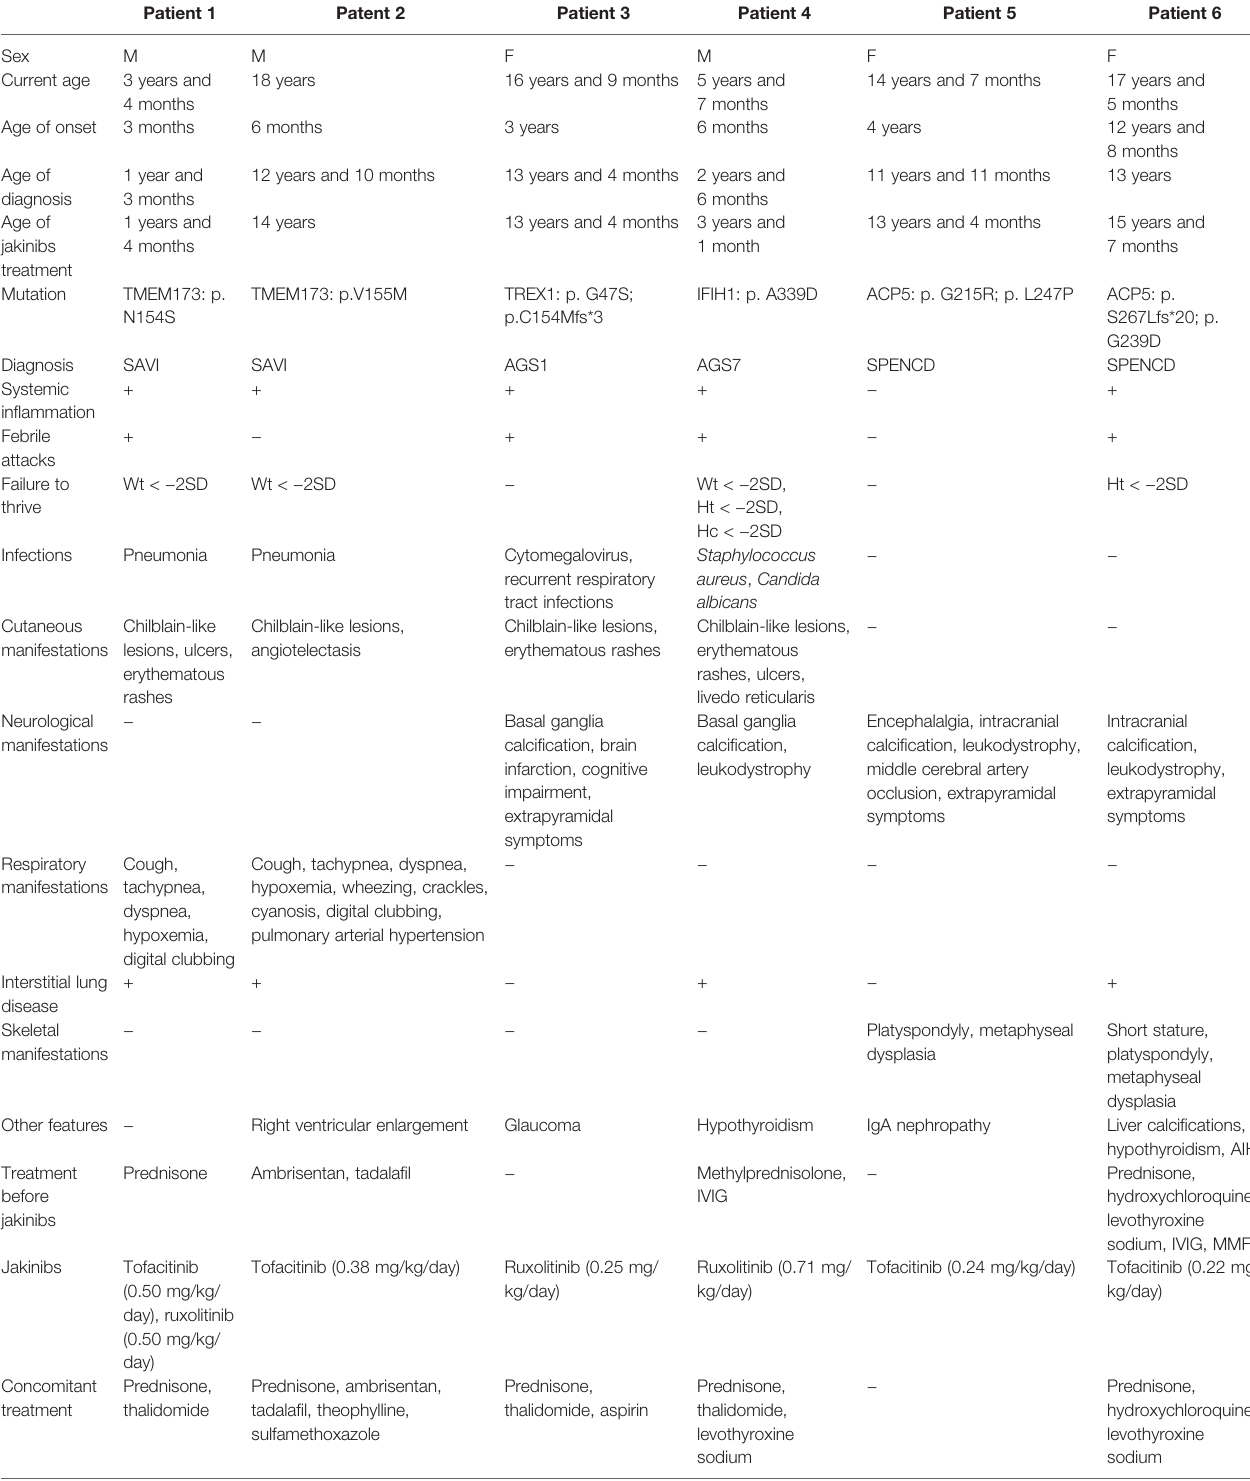
TABLE 1 | Clinical manifestations, treatment of IFNopathies